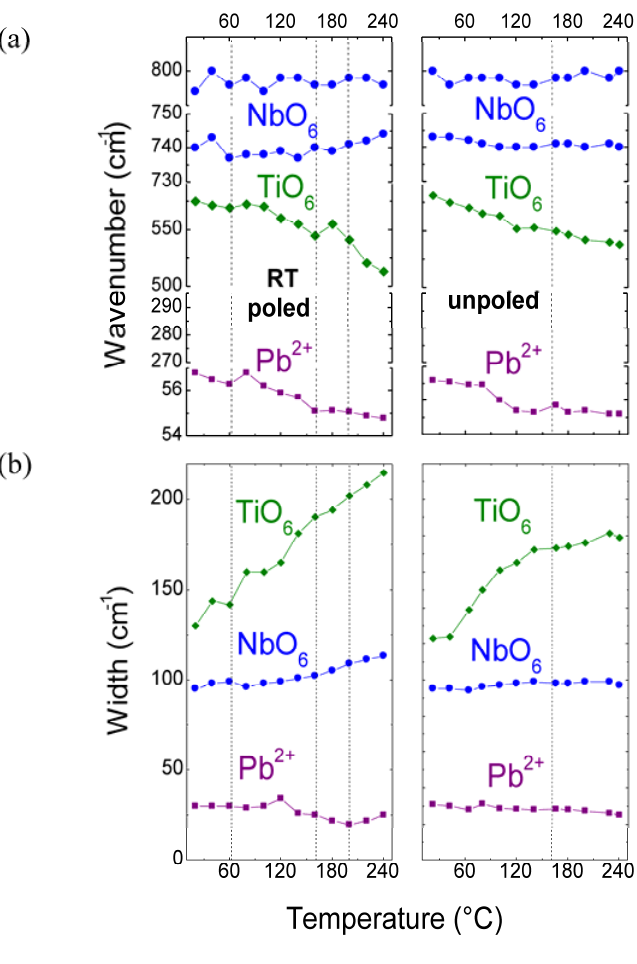
Figure 6. Temperature dependences of Raman mode wavenumbers ( a ) and widths ( b ) for RT poled and unpoled highly textured ceramic. The dashed lines represent the phase transition temperature determined from the dielectric and thermal expansion measurements. Note that since the heating rates are very different for Raman scattering and other techniques a shift of a few degrees is likely